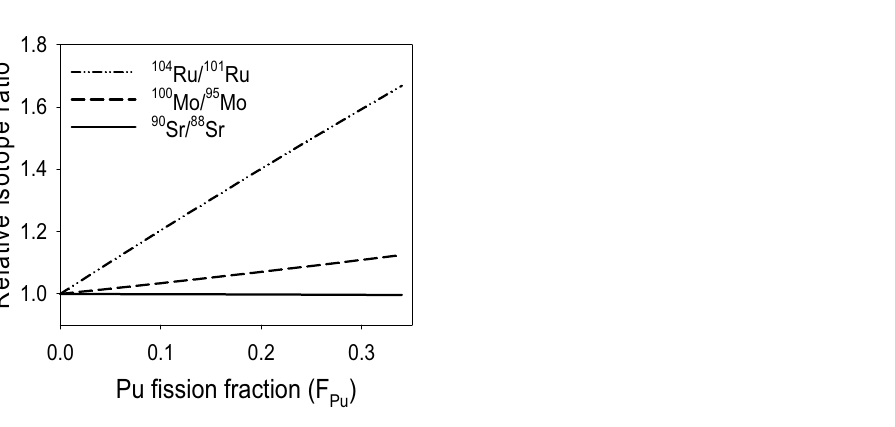
Figure 6. Expected change in selected Sr, Mo, and Ru isotope ratios due solely to fission yield as a function of Pu fission fraction ( F Pu ). Ratios are normalized to their values at F Pu =